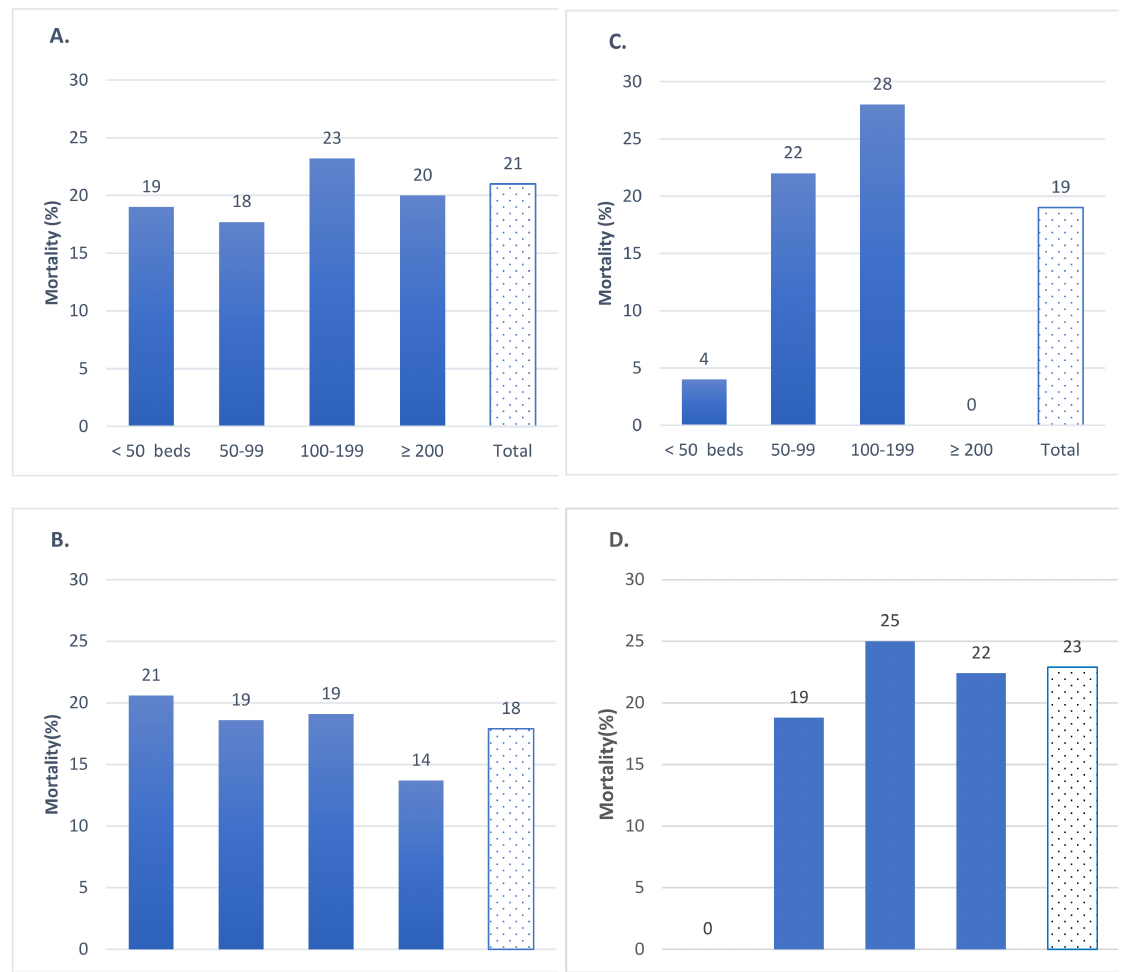
Figure 2. All-cause mortality by LTCH size in LTCHs under PPPs, Community of Madrid, March–April 2020. ( A ) For profit with rented places ( B ) Nonprofit with rented places ( C ) Municipal LCTHs with indirect administrative management ( D ) Regional LCTHs with indirect administrative management.